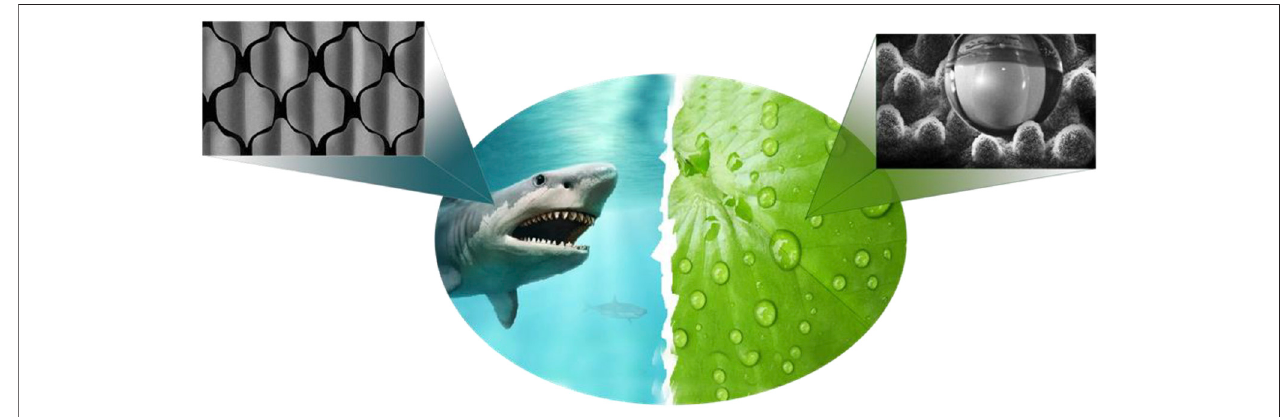
FIGURE 4 | Examples of hydrophilic and hydrophobic surface coatings obtained by polymeric coating and by shark skin mimicking, respectively.